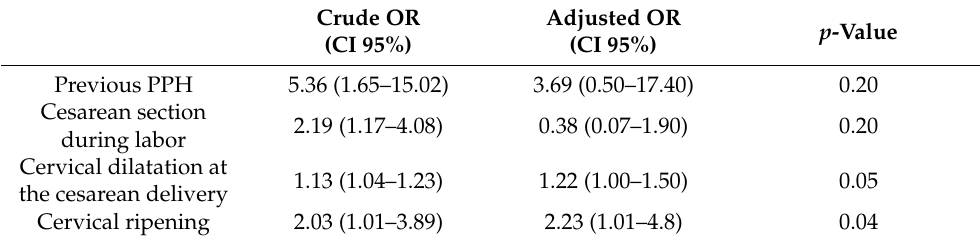
Table 3. Multivariate analysis of carbetocin failure after cesarean